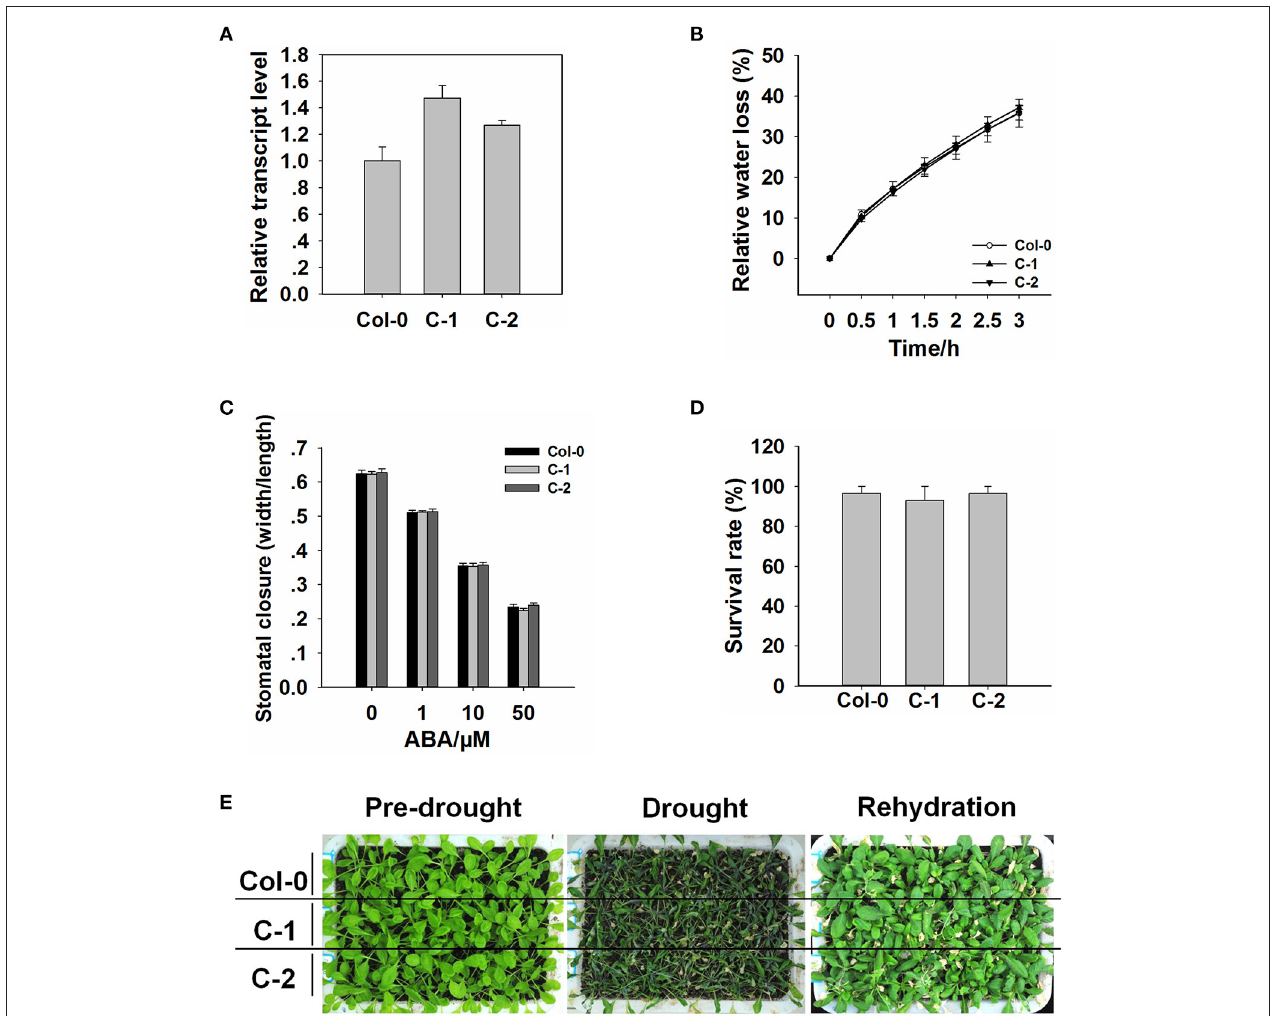
FIGURE 3 | The insertion of the p ROC3::ROC3 transgene rescues the roc3 mutants’ phenotype. (A) Relative ROC3 transcript abundances assessed using qRT-PCR in WT and the complementation lines C-1 and C-2. Error bars represent the SE ( n = 3). (B) The rate of water loss from rosette leaves detached from WT, C-1, and C-2 plants. Values shown in the form mean ± SE ( n = 3). (C) ABA-induced stomatal closure in the WT, C-1, and C-2 leaf epidermis, stomatal aperture width/length ratios measured in at least 60 stomata per genotype per replicate. Data are shown as means ± SE ( n = 60). (D) The survival rate of WT, C-1, and C-2 plants growing under drought stress conditions. Values shown in the form mean ± SE ( n = 3). (E) The appearance of drought-stressed WT, C-1, and C-2